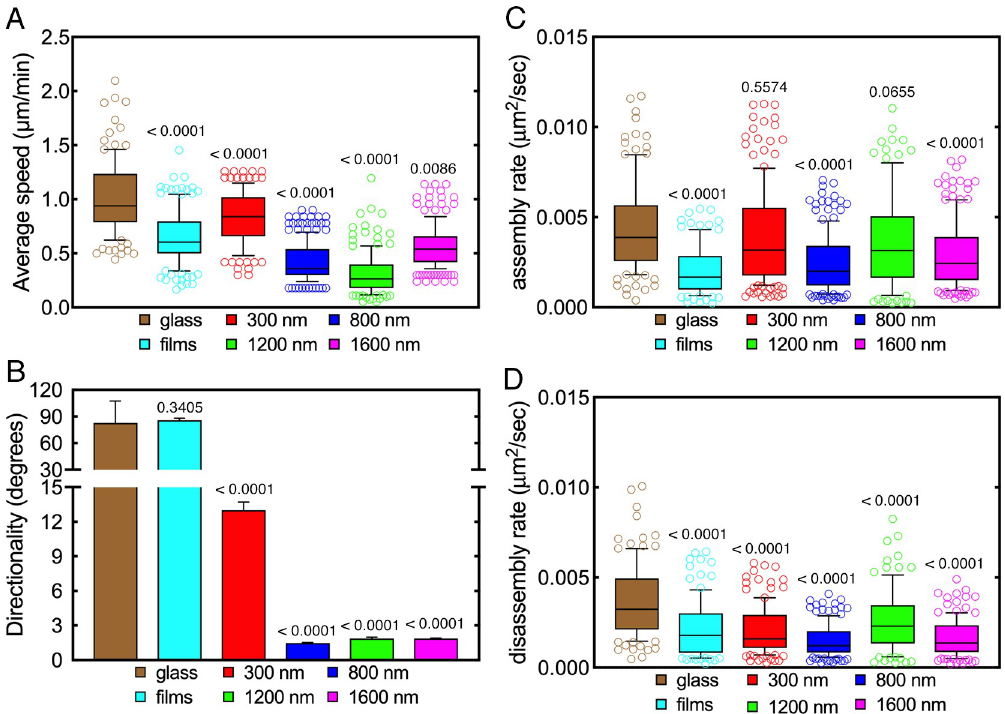
Fig 9. Impact of the spacing of microgel arrays on cell migration and focal adhesion turnover. (A, B) Box plots showing the impact of microgel array spacing on average speed (A) and directionality (B) of B16F1 cell migration. Compared to a control substratum (glass), B16F1 cells move significantly more slowly on microgel films. Their migration is even slower on 800 nm, 1200 nm and 1600 nm microgel arrays, but not on 300 nm microgel arrays, which support a significantly higher average speed than all other microgel substrates. Consistent with their topography, cells on microgel films display large variations in their direction of migration, similar to those on glass. The directionality of cell migration is greatly increased on 800, 1200 and 1600 nm microgel arrays, whereas cells on 300 nm microgel arrays display less directionality. (C, D) Box plots showing the impact of microgel array spacing on focal adhesion assembly (C) and disassembly (D) rates. Compared to the control substratum (glass), both focal adhesion assembly and disassembly rates on microgel films are significantly reduced. Focal adhesion assembly rate is also significantly reduced in cells seeded on to 800 and 1600 nm microgel arrays. By contrast, in cells seeded on to 300 and 1200 nm microgel arrays, focal adhesion assembly rate is not significantly different from the control. The focal adhesion disassembly rate is significantly reduced in cells on all microgel arrays. Numbers indicate p values (compared to glass). A more complete statistical analysis can be found in the in S1